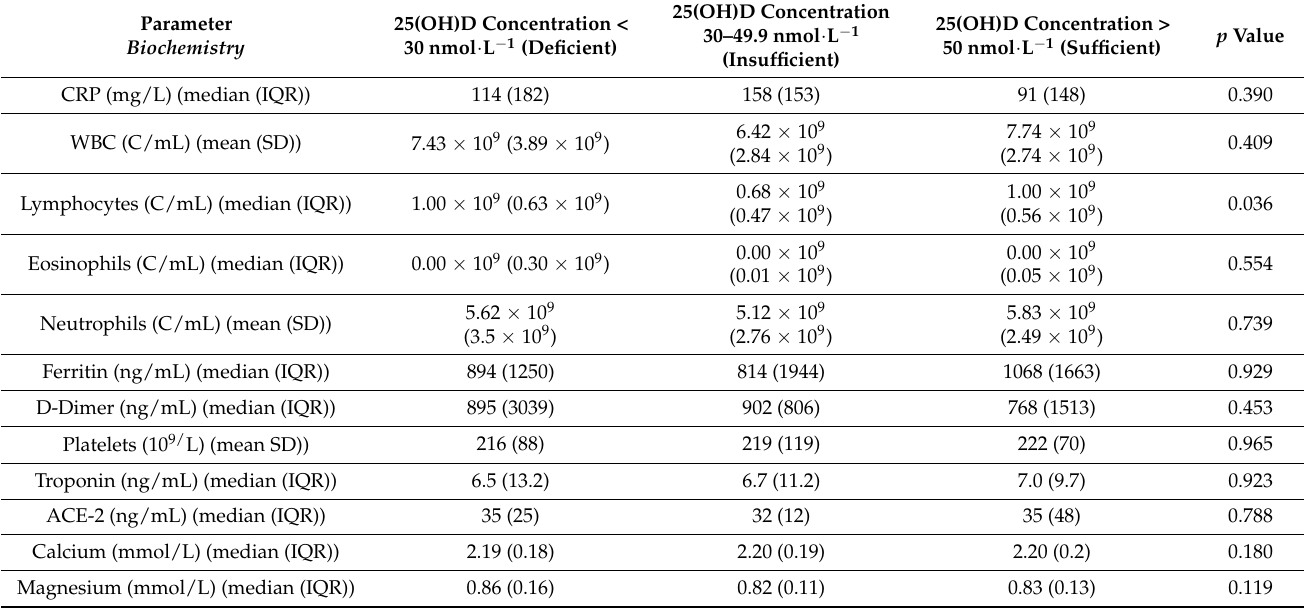
Table 2. Laboratory parameters of COVID-19 patients in relation to vitamin D status. Peak measures during hospital admission are reported. Serum 25(OH)D was measured within 24 h of admission.